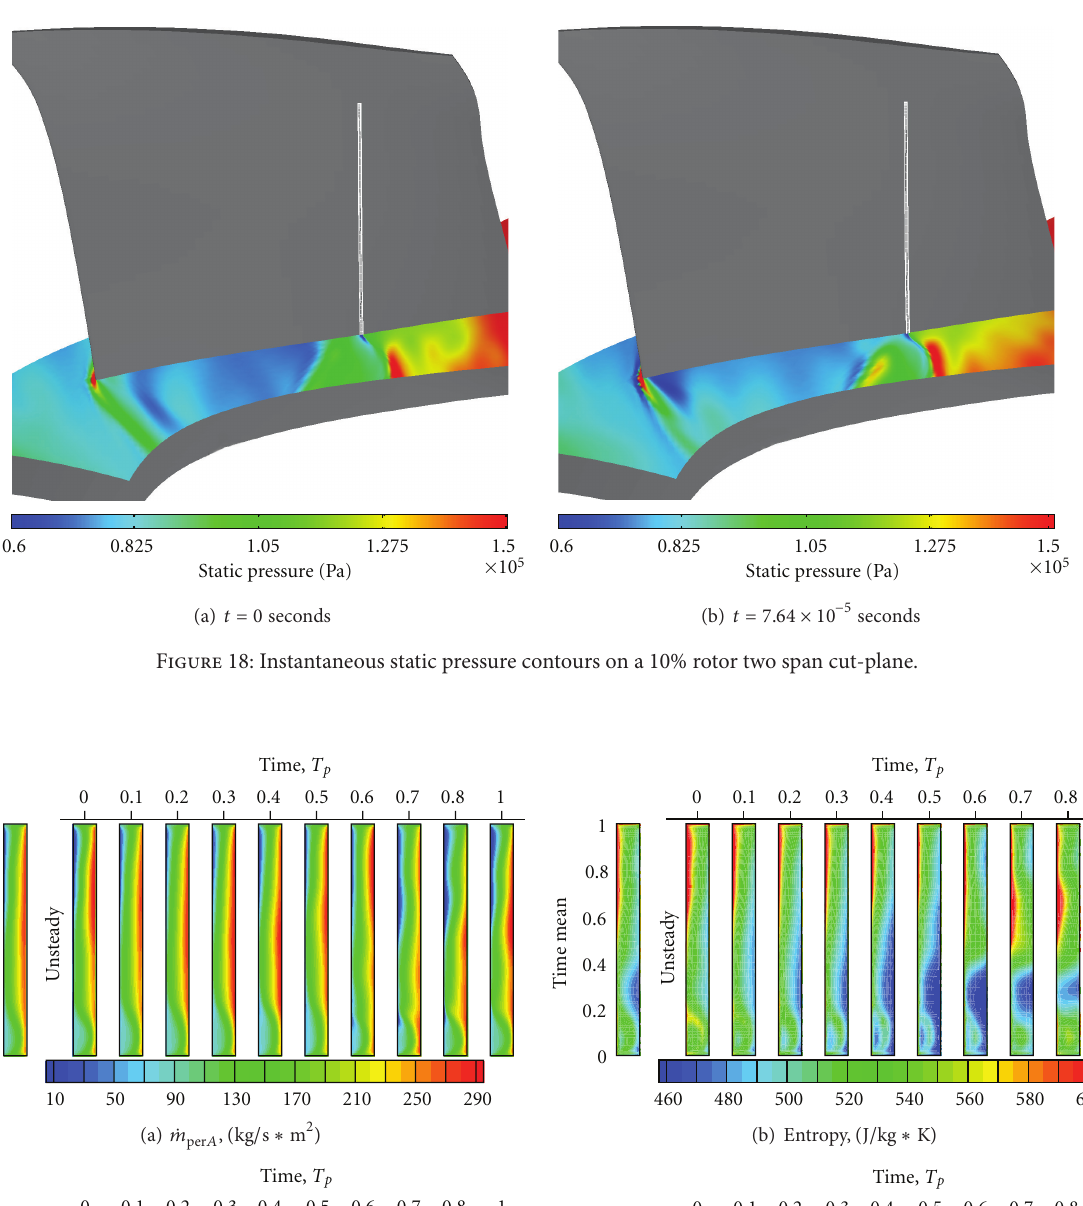
(d) Relative total temperature, seconds, which is the rotor one blade passing period. Le is −𝑡 𝑇𝑇 𝑝𝑝 𝑡 𝑡𝑡2𝑡3 𝑡 𝑡𝑡